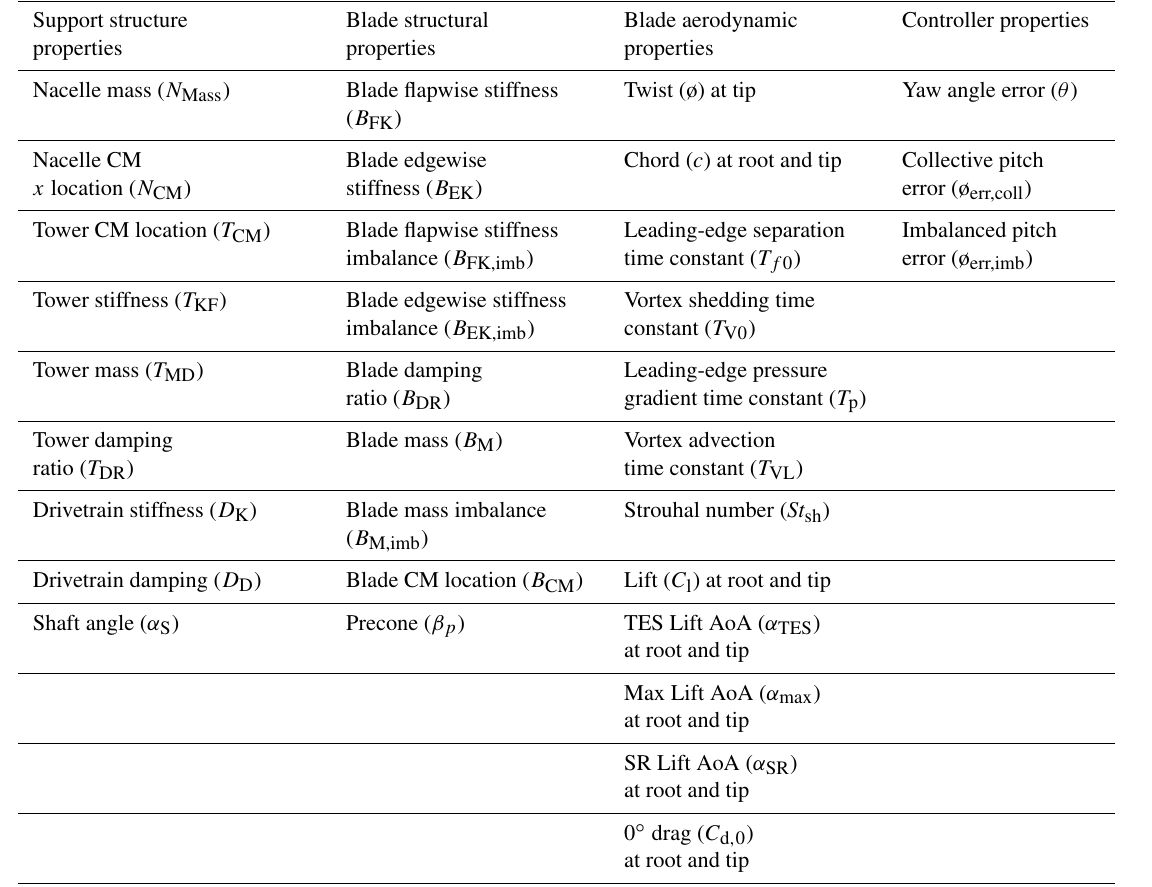
Table 6. Turbine aeroelastic parameters (39 total).